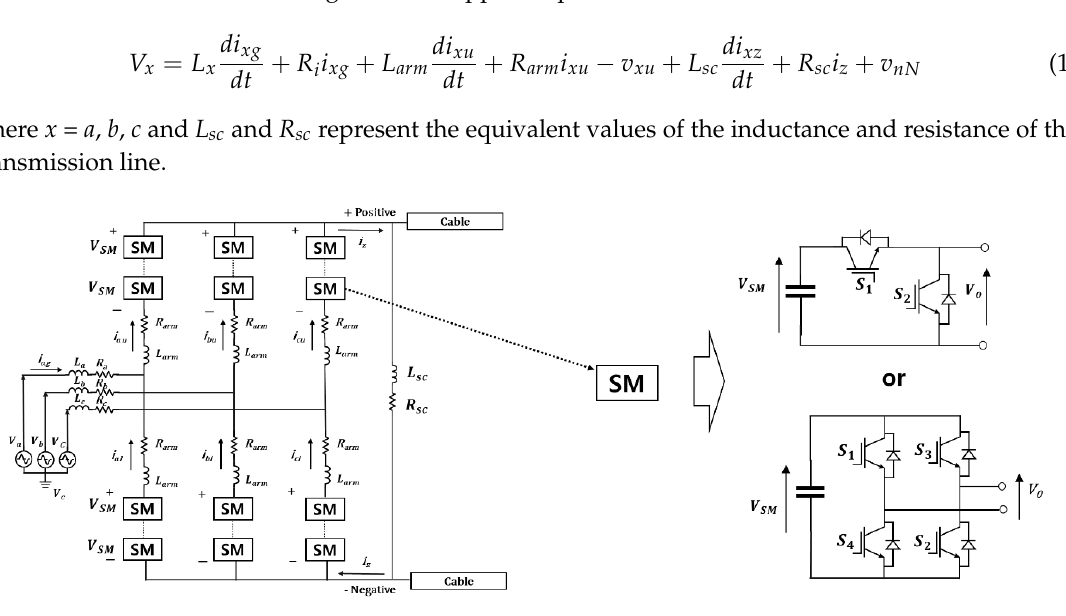
Figure 1. Equivalent circuit of a modular multilevel converter (MMC) system composed of a half bridge (HB) or full bridge (FB) configuration.